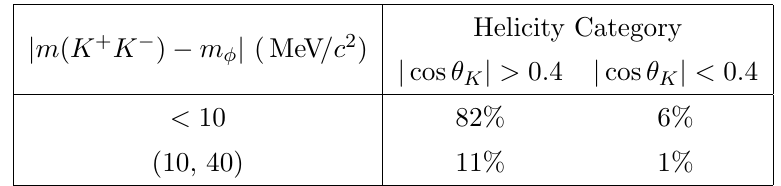
Table 1. Fractions of B + ! D + (cid:30) candidates expected in the helicity and m ( K + K (cid:0) ) invariant s mass categories of the simultaneous (cid:12)t.